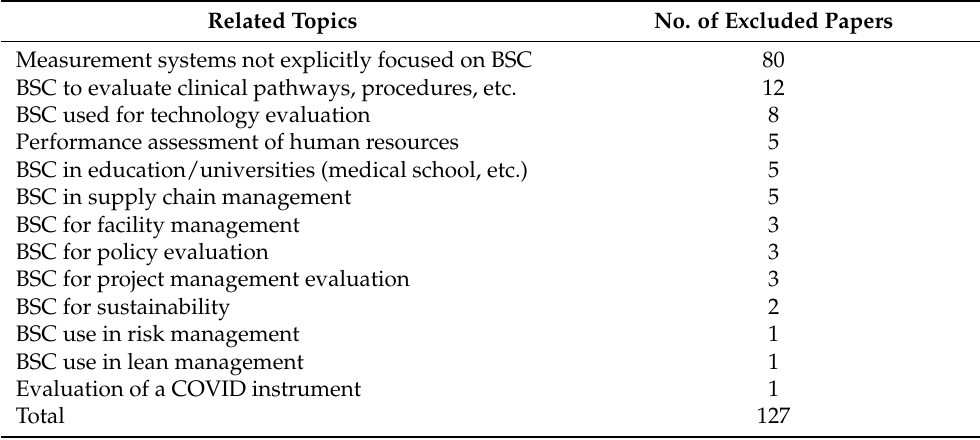
Table 2. Excluded papers according to the second criterion during the screening phase.